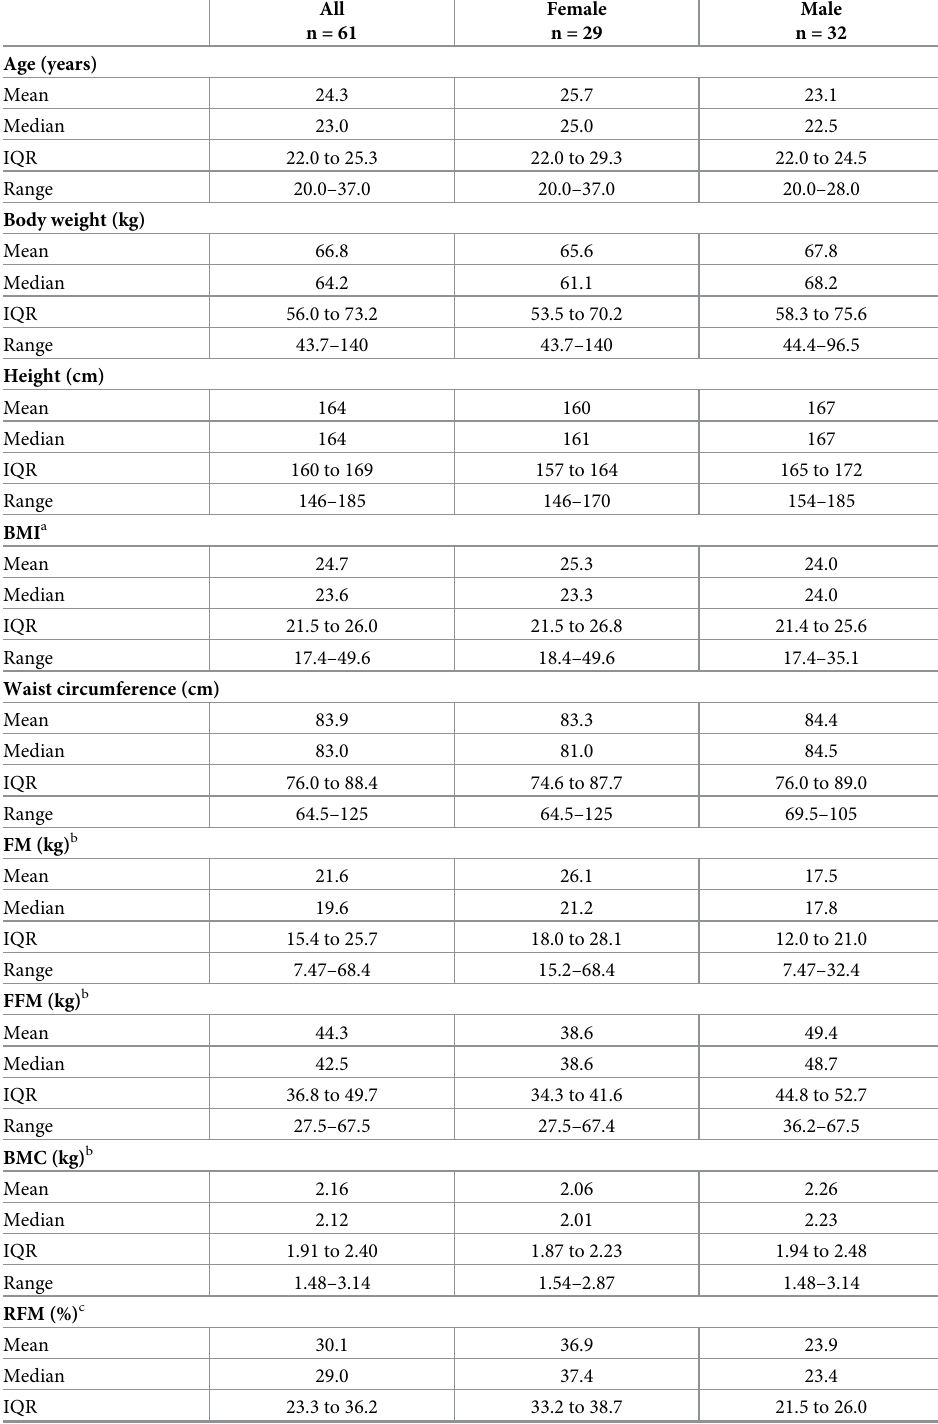
Table 2. Physical and anthropometric